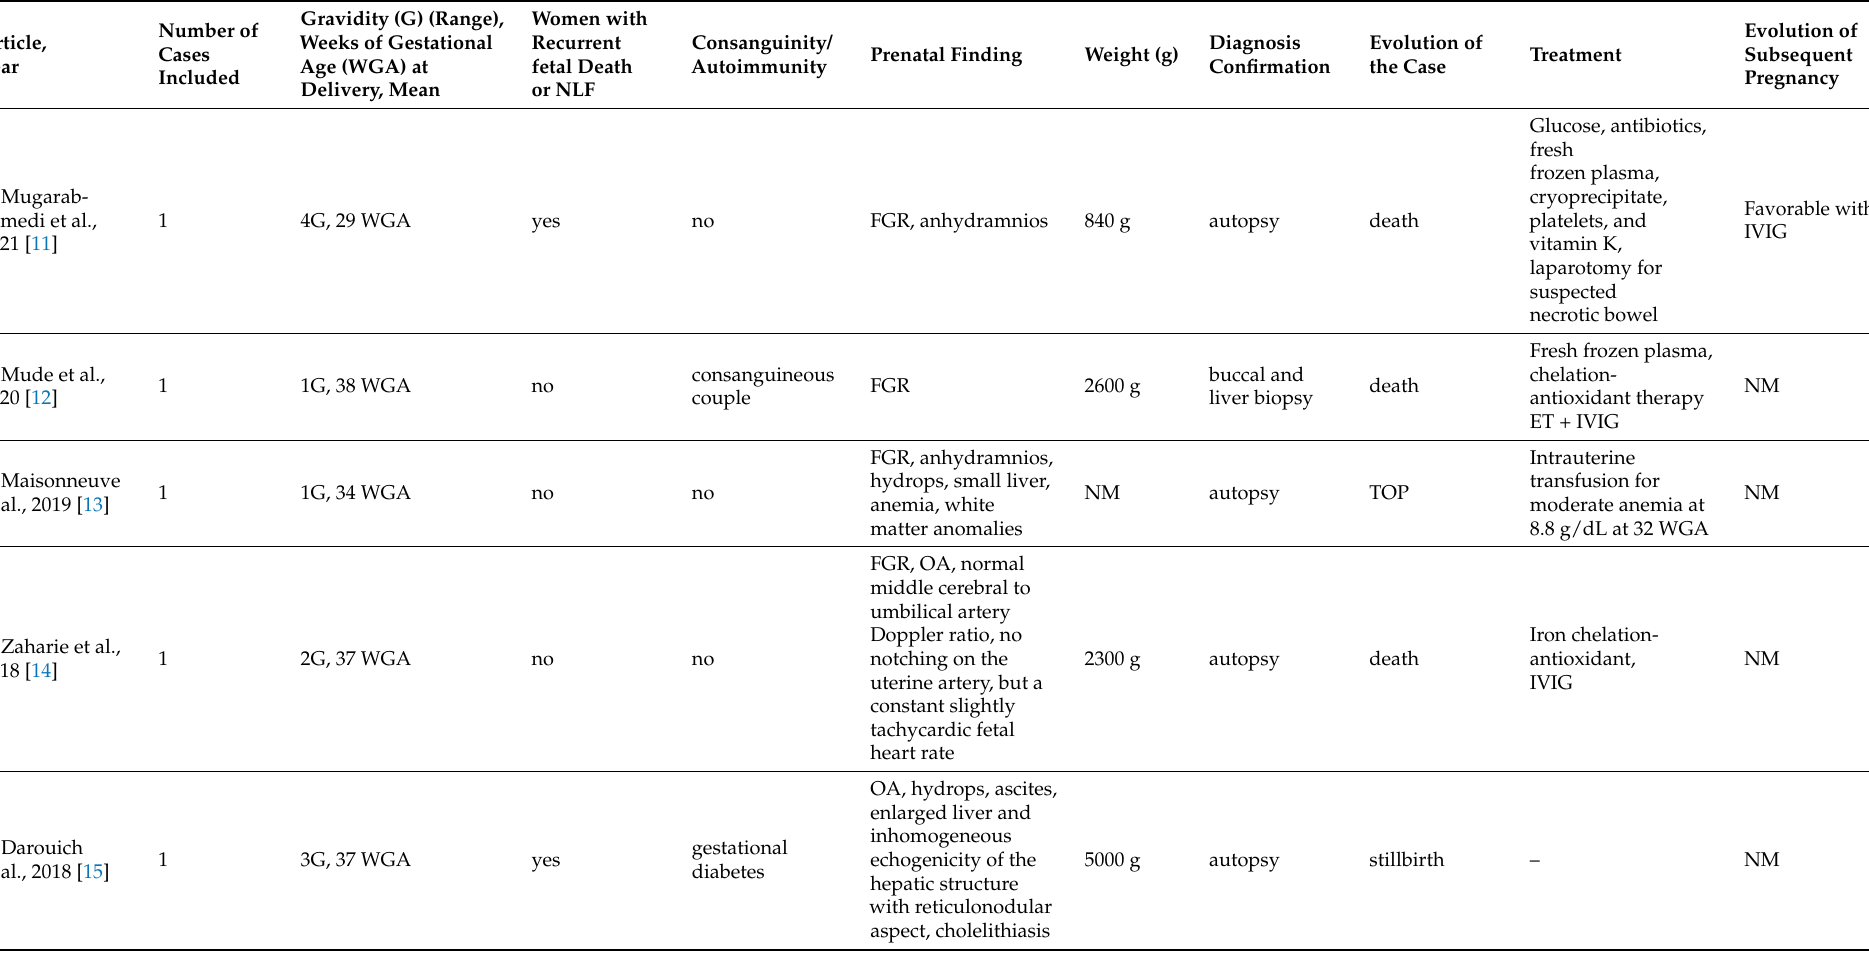
Table 1. Literature review of the cases diagnosed with neonatal hemochromatosis, with confirmed extrahepatic siderosis (1993 to 2021) and maternal medical and obstetric history, prenatal findings, postpartum outcome, and subsequent pregnancy